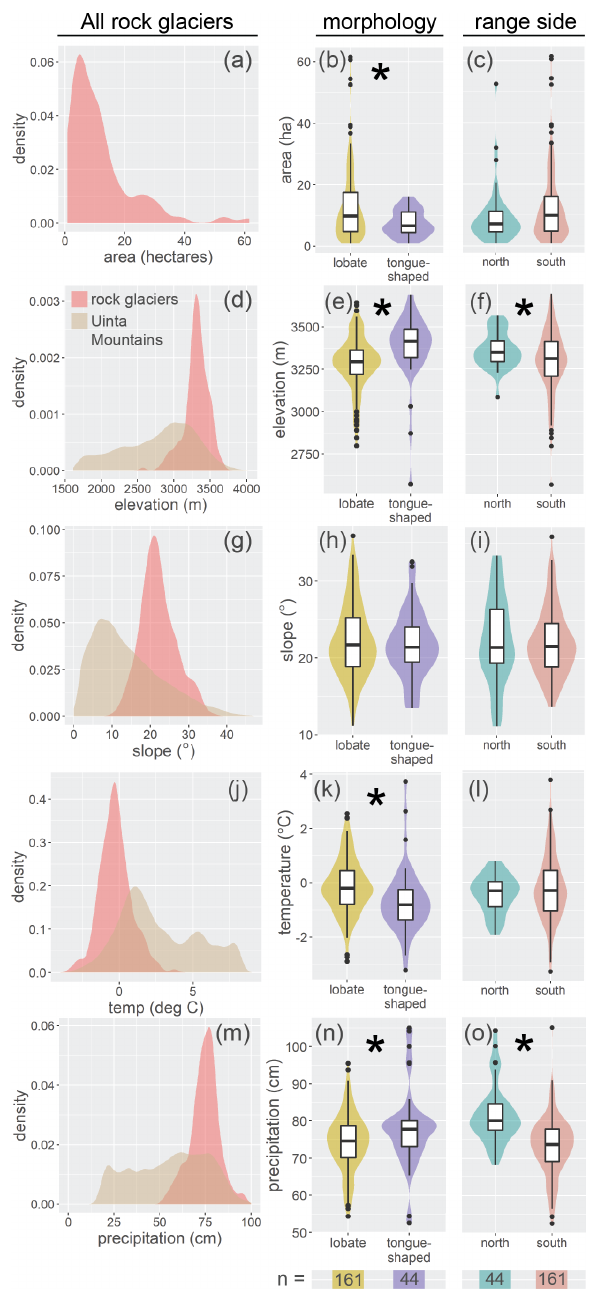
Figure 4. Characteristics of active rock glaciers in the Uinta Moun- tains. Slope, area, and elevation were calculated using the rock glacier inventory polygons and a DEM in QGIS. Temperature and precipitation were calculated using the rock glacier inventory poly- gons and PRISM data in QGIS. (a, d, g, j, m) Data for all rock glaciers and the Uinta Mountains shown as kernel density plots. (b, c, e, f, h, i, k, l, n, o) Colored violin plots on the right show rock glacier characteristics based on morphology and location within the Uintas. Asterisks denote statistically significant differences, and n =